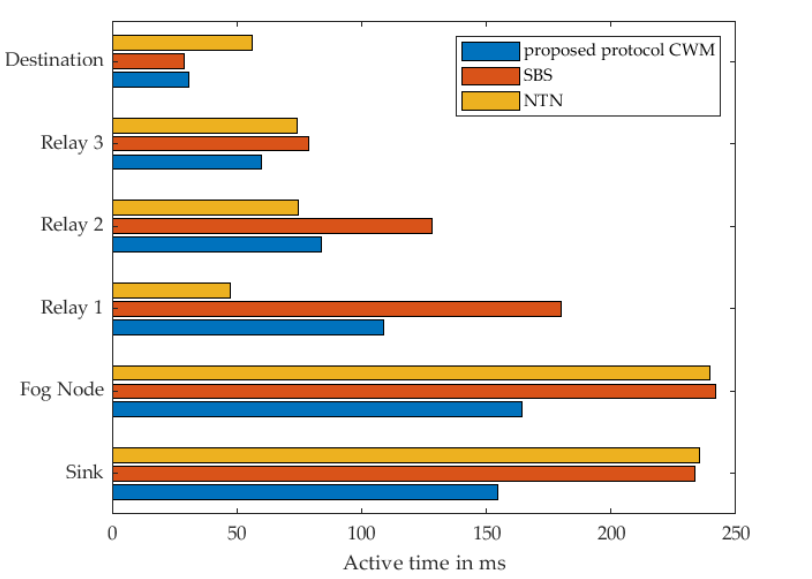
Figure 16. Measured time of every single node in active mode using 3